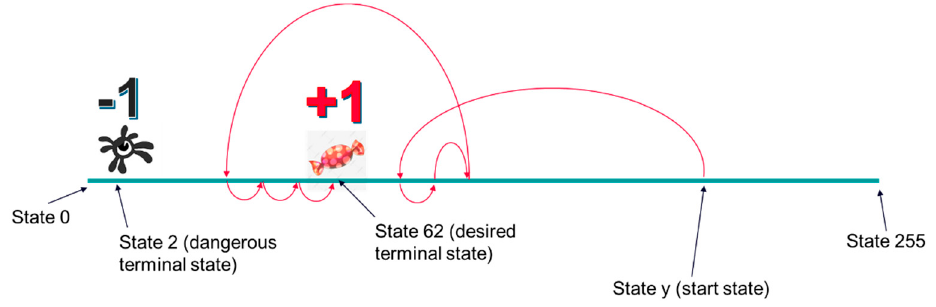
Figure 4. Reward scheme used in the first training setup. Only a desired terminal state and a dangerous terminal state are represented in the picture.